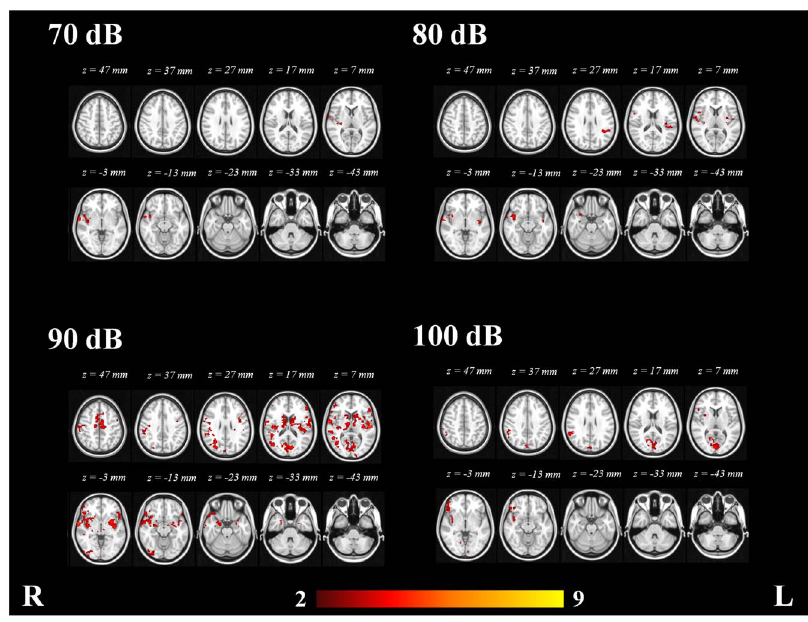
Figure 4. Voxel-wise statistical map of the significant clusters showing covariance with N1/P2 amplitudes at 70, 80, 90 and 100 dB. Color bar represents Z-scores.